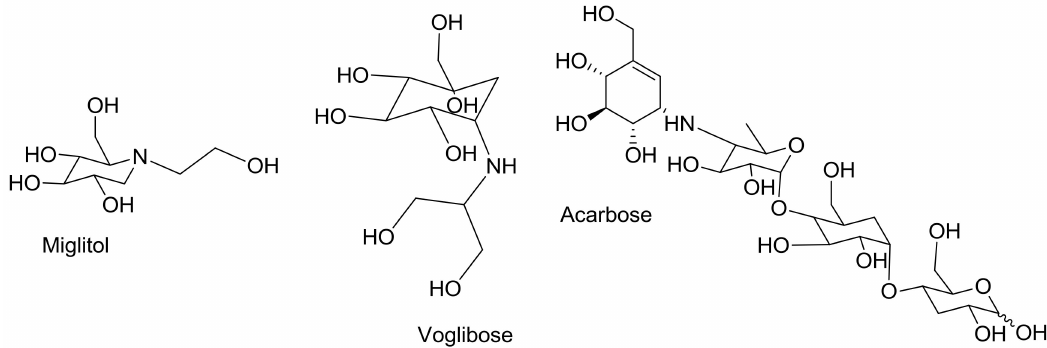
Figure 1. Structures of some of the available α -glucosidase